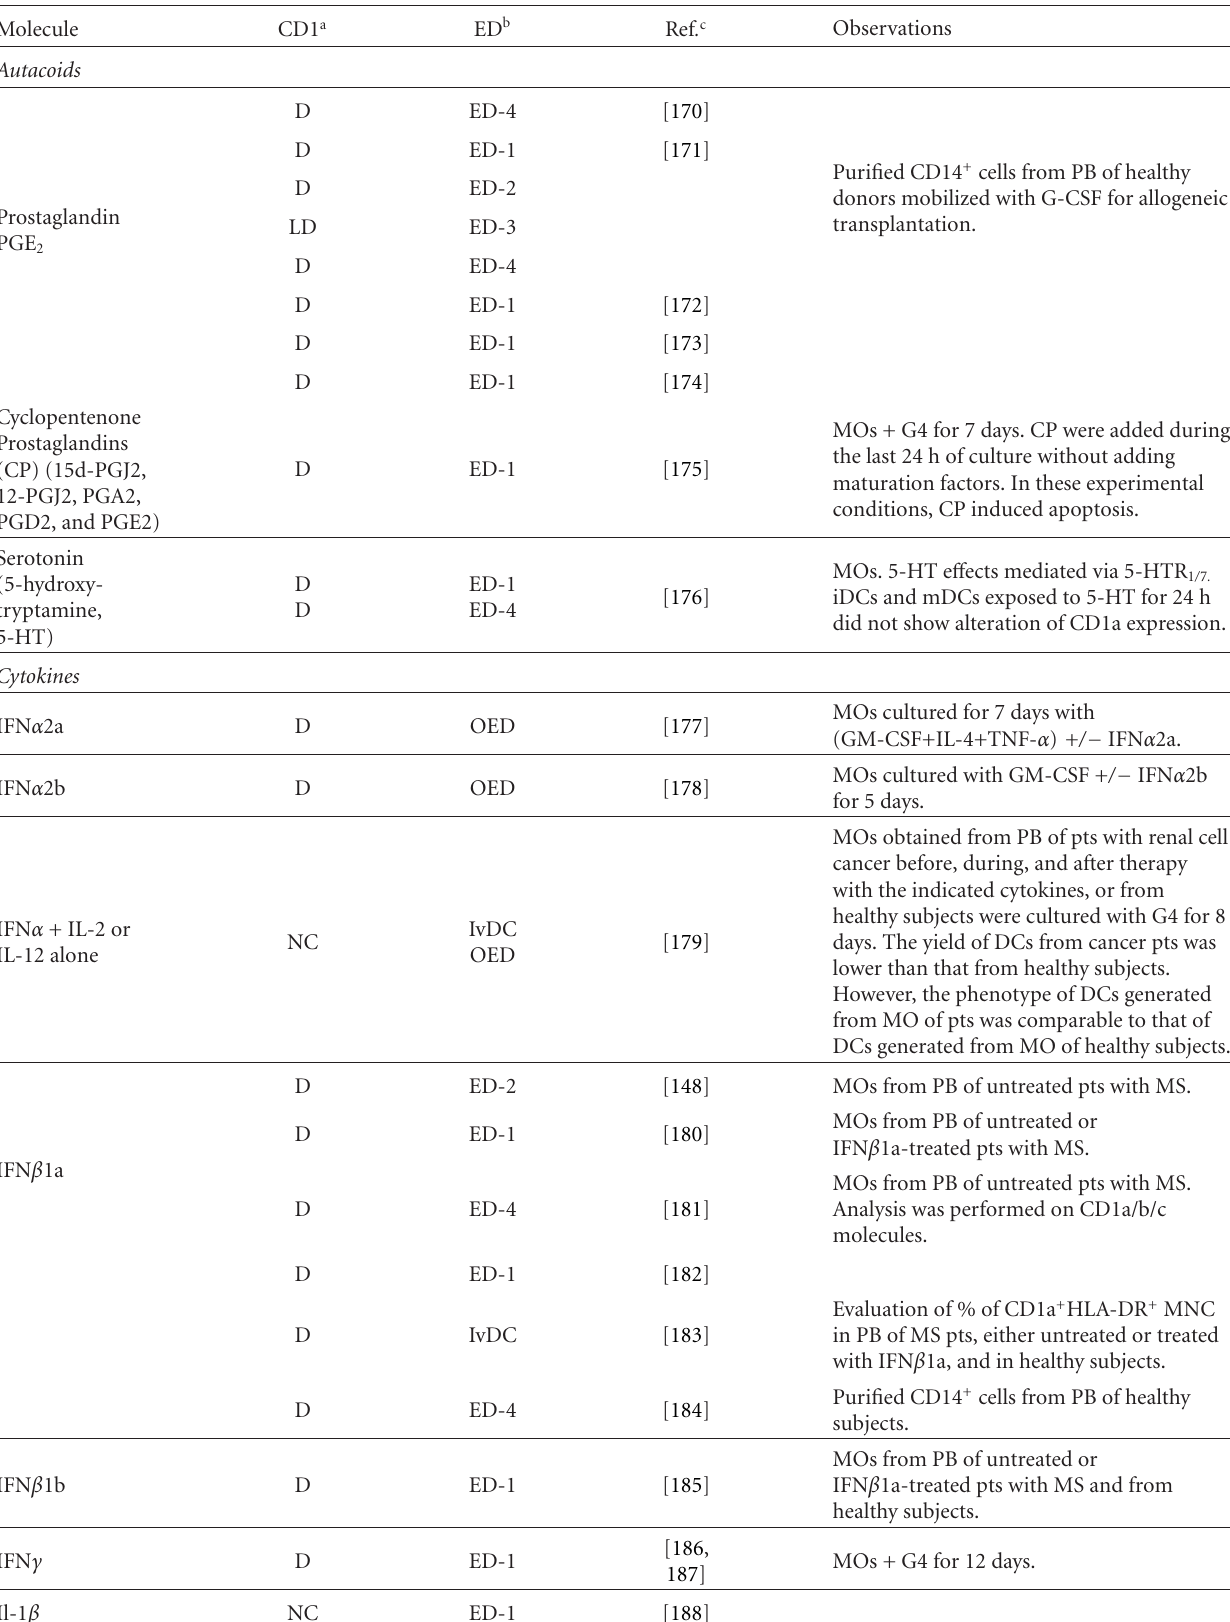
Table 3: E ff ect of autacoids or cytokines on CD1 molecule